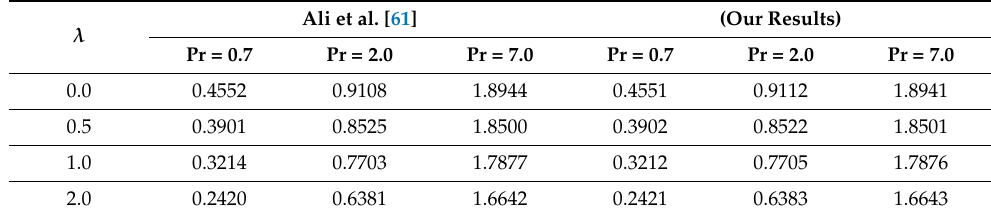
Table 4. − θ (cid:48) ( 0 ) value along with distinct values of λ .